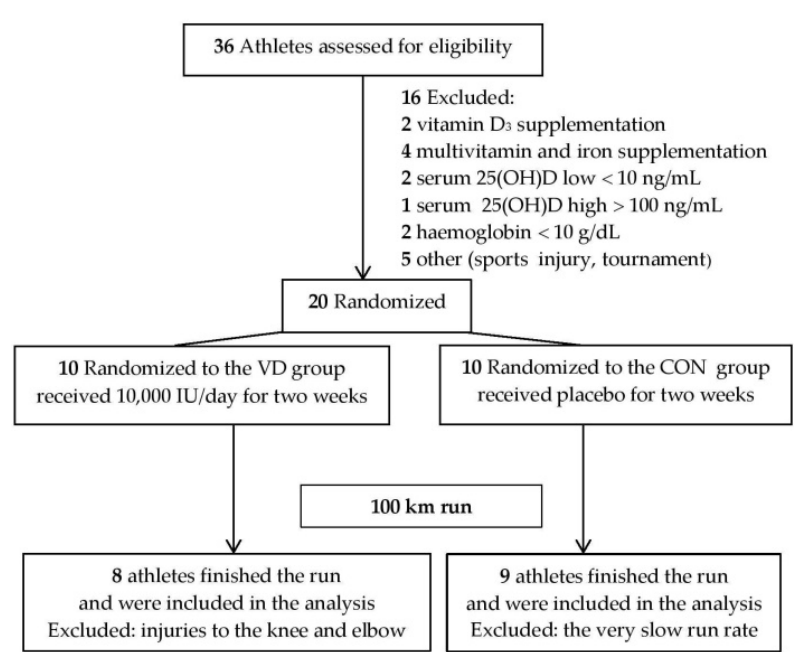
Figure 1. Flow diagram of inclusion and exclusion of athletes through the study. VD—supplemented with vitamin D 3 ; CON—placebo group; IU—international units. Table 1. Comparison of subjects’ baseline characteristics (mean ± standard